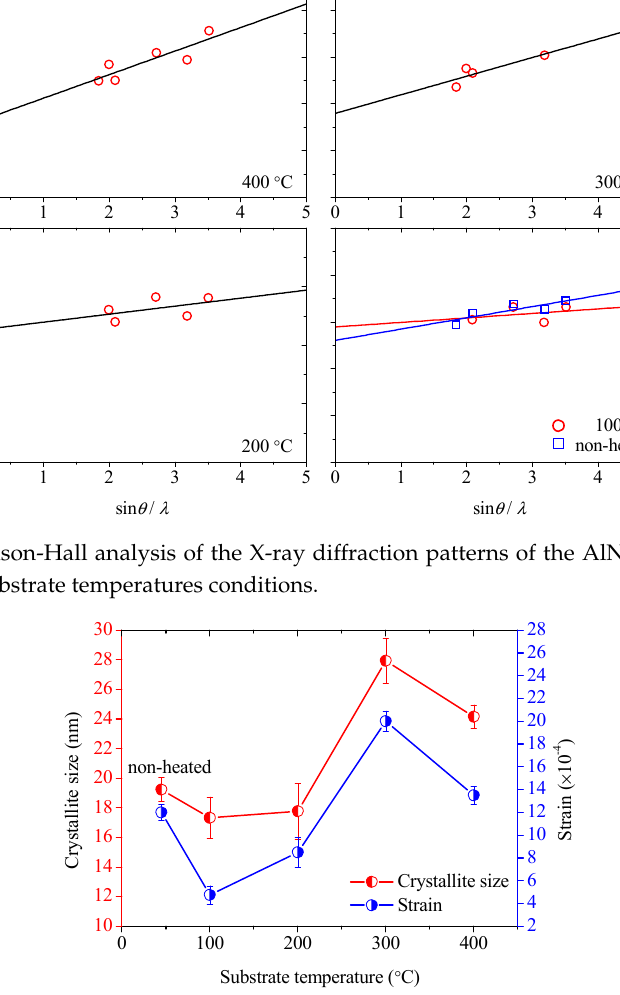
( b ) Figure 11. Dependence of AlN:Er film ( a ) thickness and ( b ) refractive index on the substrate temperature.